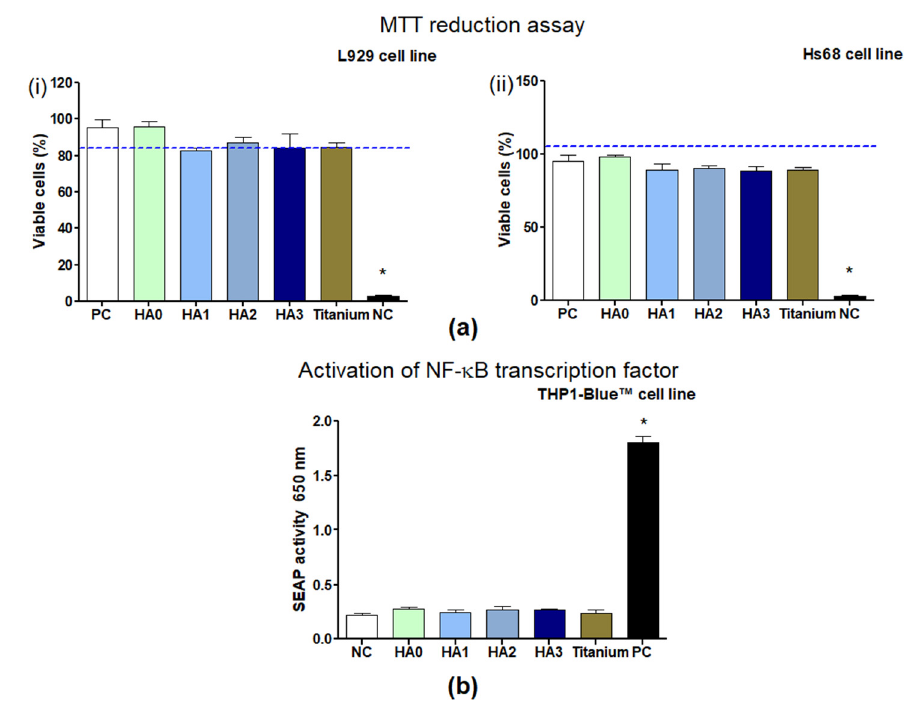
Figure 8. Biocompatibility of hydroxyapatite (HA)-coated titanium probes. ( a ) viability of ( i ) murine fibroblasts L929 or ( ii ) human fibroblasts Hs68, incubated for 24 h with bare titanium plates alone, such plates modified with HA (HA1, HA2, HA3), or with HA in solution (HA0), evaluated by 3-(4,5-dimethylthiazol-2-yl)-2,5-diphenyltetrazolium bromide (MTT) reduction assay according to ISO-10993-5:2009. Complete RMPI-1640 medium (cRPMI) was used as a positive control (PC) of cell viability (100% viable cells) and 0.03% H 2 O 2 as a negative control (NC) of cell viability (100% dead inactive cells). The blue line indicates the minimal percentage of viable cells (70%) required to confirm the biomaterial as non-cytotoxic at the in vitro level C. ( b ) Activation of nuclear factor kappa B (NF- κ B) in THP1-Blue™ monocytes incubated for 24 h with bare titanium plates alone, such plates modified with HA (HA1, HA2, HA3), or with HA (powder) in solution (HA0) was determined on the basis of secreted embryonic alkaline phosphatase (SEAP) activation. Cells incubated without composites served as a negative control of the monocyte activation (NC), and monocytes stimulated with lipopolysaccharide (LPS) of E. coli served as a positive control (PC). Data are presented as mean ± SD of three separate experiments (six replicates for each experimental variant). Statistical significance: * p < 0.05; * untreated cells vs. cells treated with tested biomaterial.